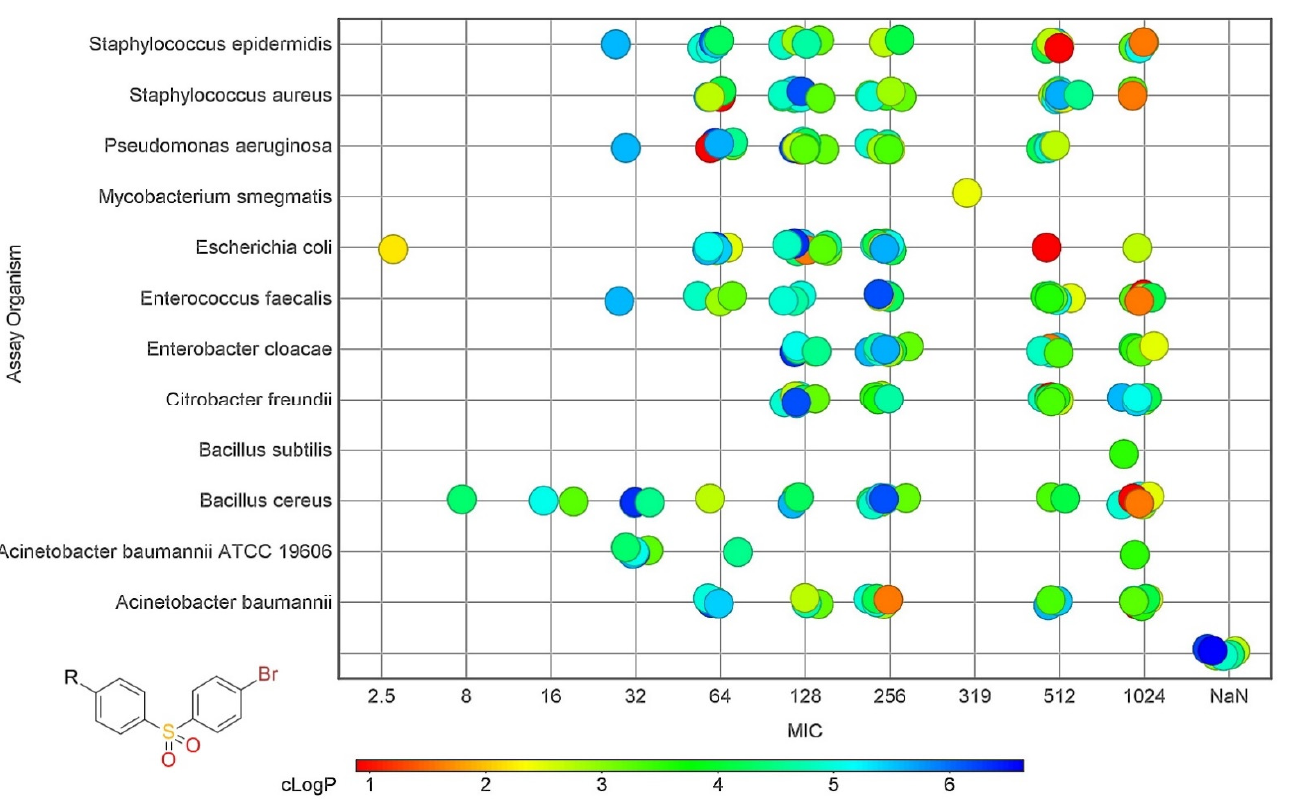
Figure 2. MIC values for the compounds resulted after the substructure search based on the 1- bromo-4-(phenylsulfonyl)benzene scaffold. NaN presents the new compounds 5 , 6 , 7a , b , and 8a , b .